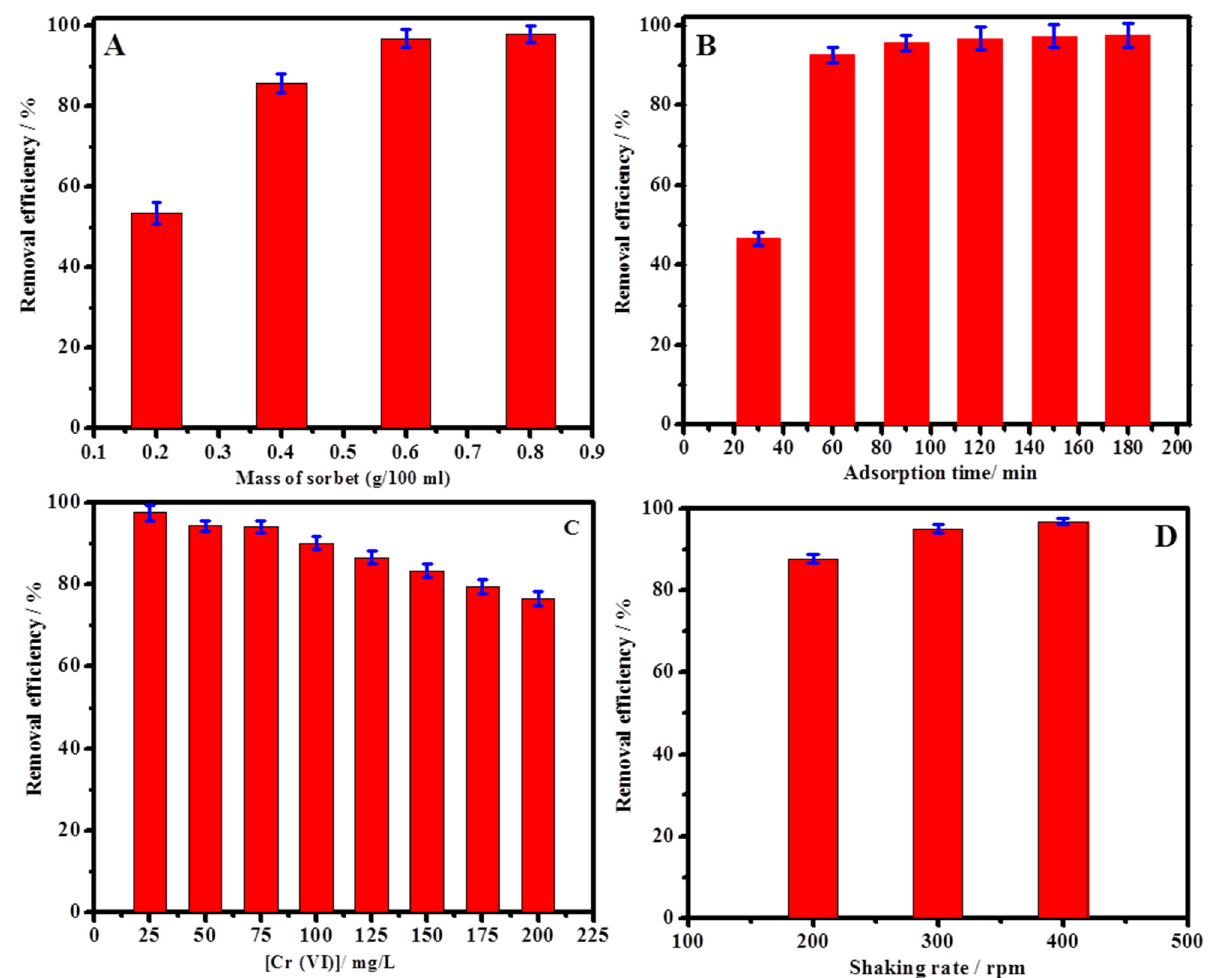
Figure 3. Influence of the sorbet weight (100 mL solution of 100 mg/L Cr(VI)) ( A ), contact time (0.6 g Fe(0)@AC; 100 mg/L Cr(VI),) ( B ), initial [Cr (VI)] (0.6 g FE(0)@AC) ( C ), and shaking rate 100 mg/L Cr(VI), 0.6 g Fe(0)@AC, adsorption time 90 min) ( D ) on the removal efficiency (adsorption) of Cr (VI) by Fe(0)@AC; pH = 2, at 25 ◦